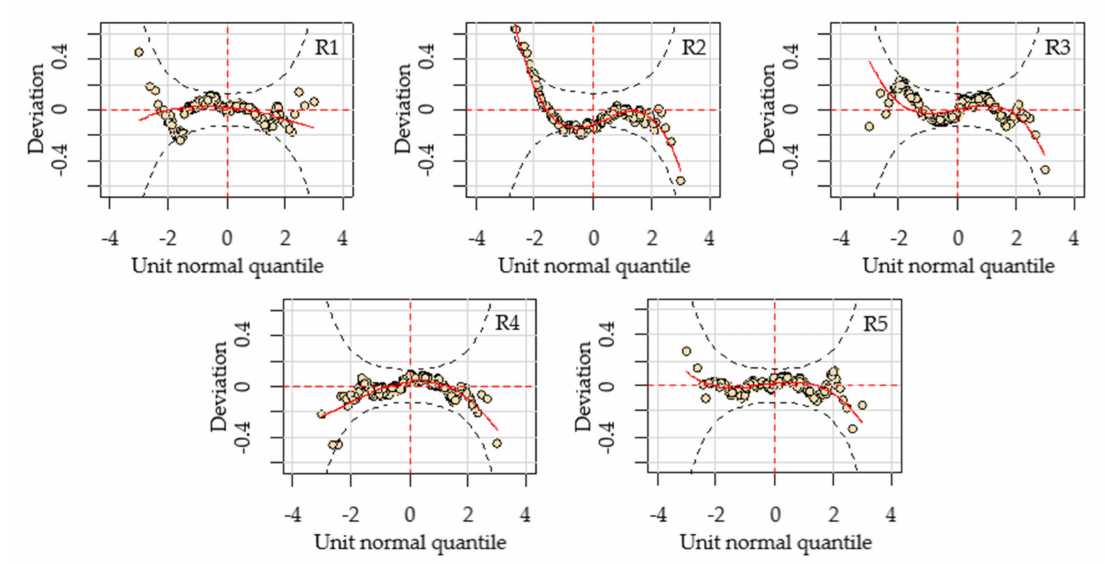
Figure 6. Residual diagnosis of the GAMLSS model characteristic of each homogeneous region in scenario S2, by structural worm-plot